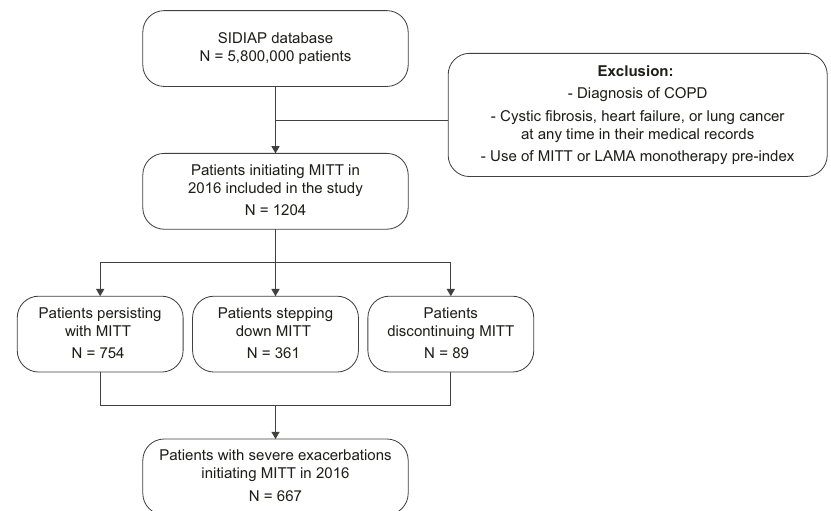
Fig. 2 Flow chart of the patient selection from the SIDIAP database. COPD chronic obstructive pulmonary disease, LAMA long-acting muscarinic antagonist, MITT multiple-inhaler triple therapy, SIDIAP Information System for Research in Primary